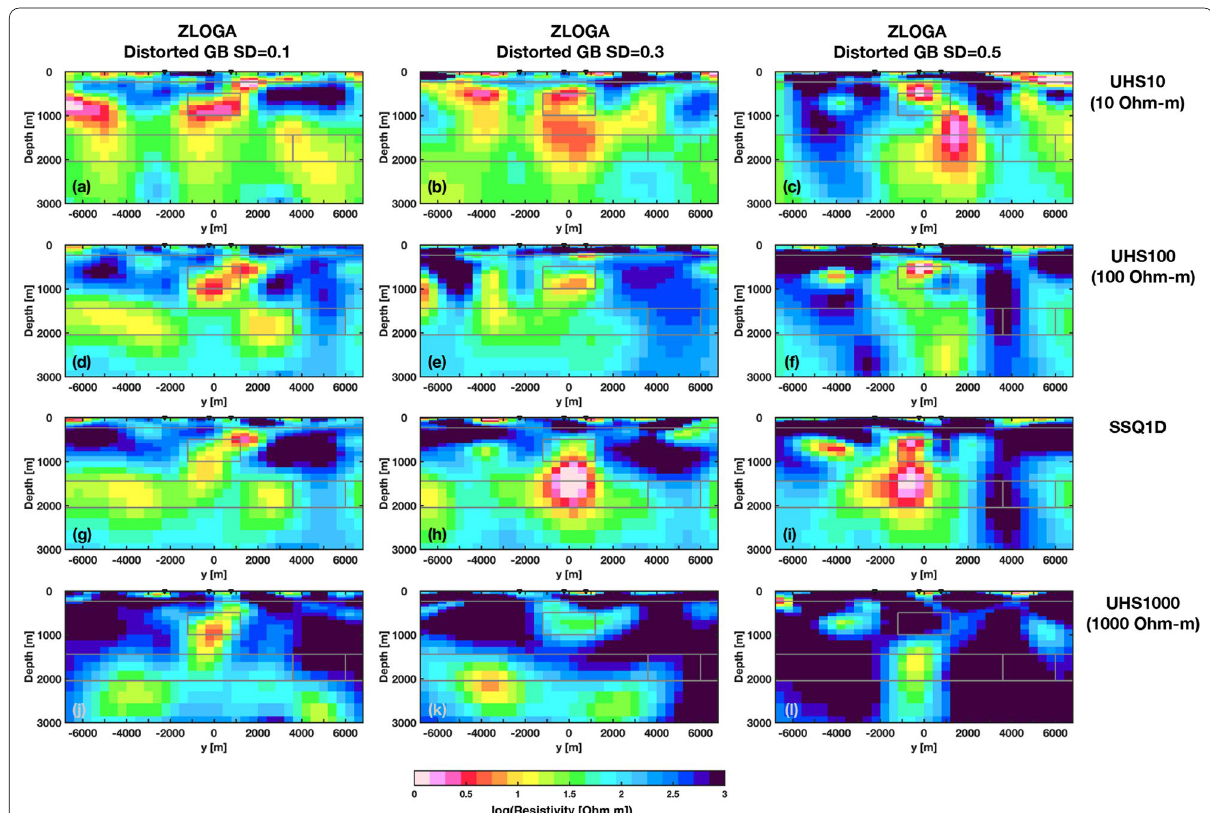
Fig. 10 NS cross sections at the easting of 200 m of the models inverted from the off‑diagonal elements (ZLOGO) of the distorted MT impedance tensor using differential initial